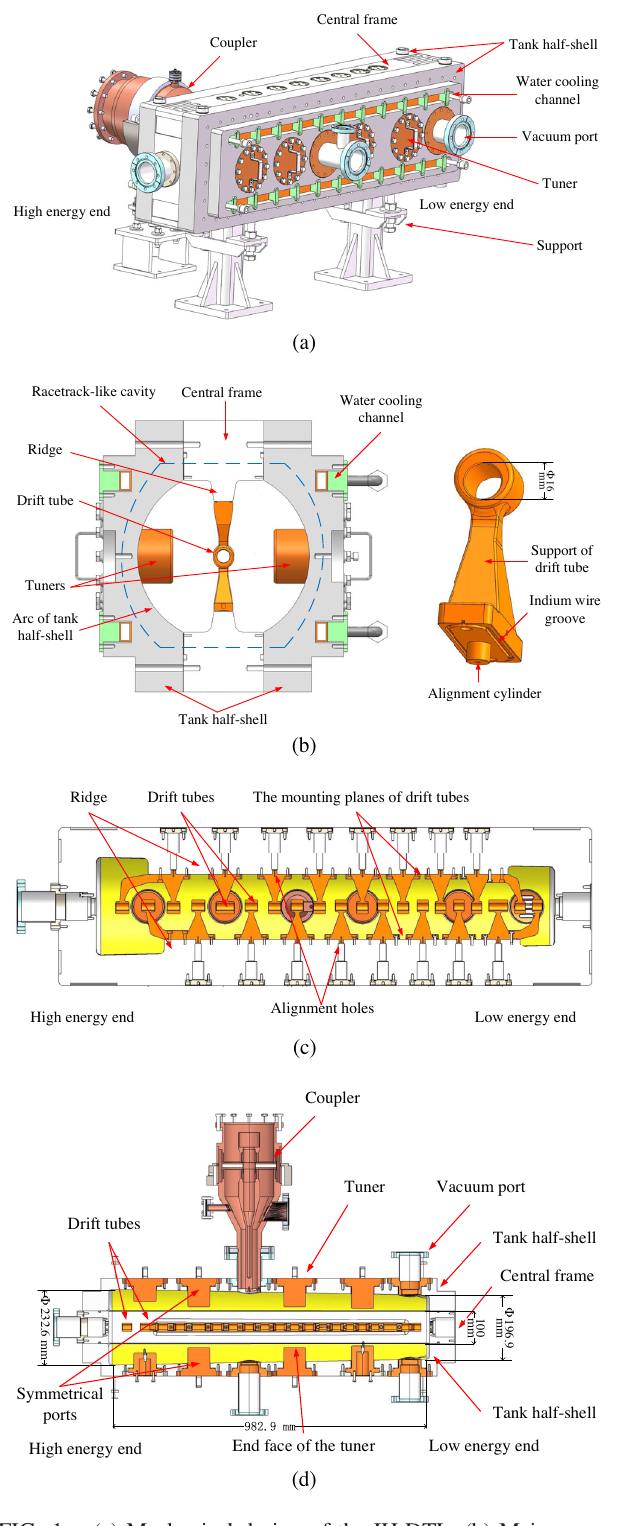
FIG. 3. Central frame with the aligned DTs and tank half-shell: (a) alignment of DTs; (b) central frame with DTs; (c) tank